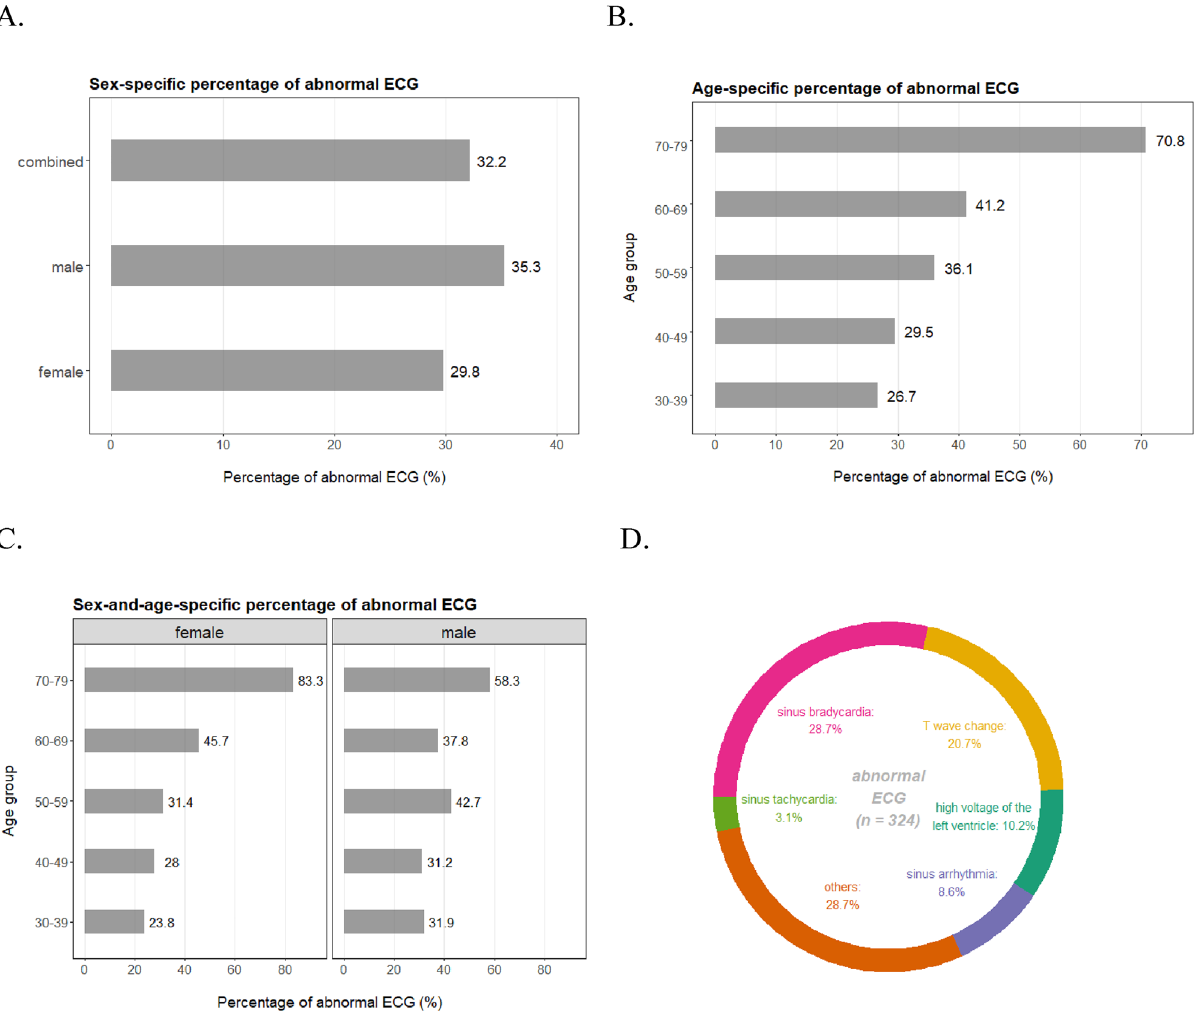
Figure 1. Percentage of abnormal ECG assessment by sex ( A ), age ( B ), sex and age ( C ), and subtypes of ECG issues ( D ) in the